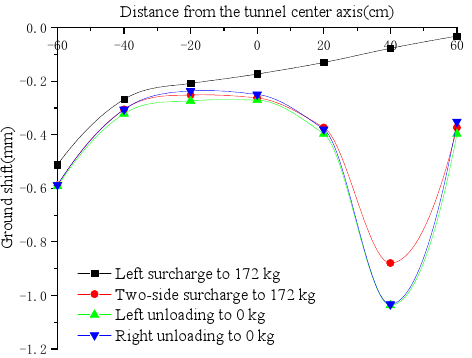
Figure 12. Variation in ground shift under different surcharges for Case 3.